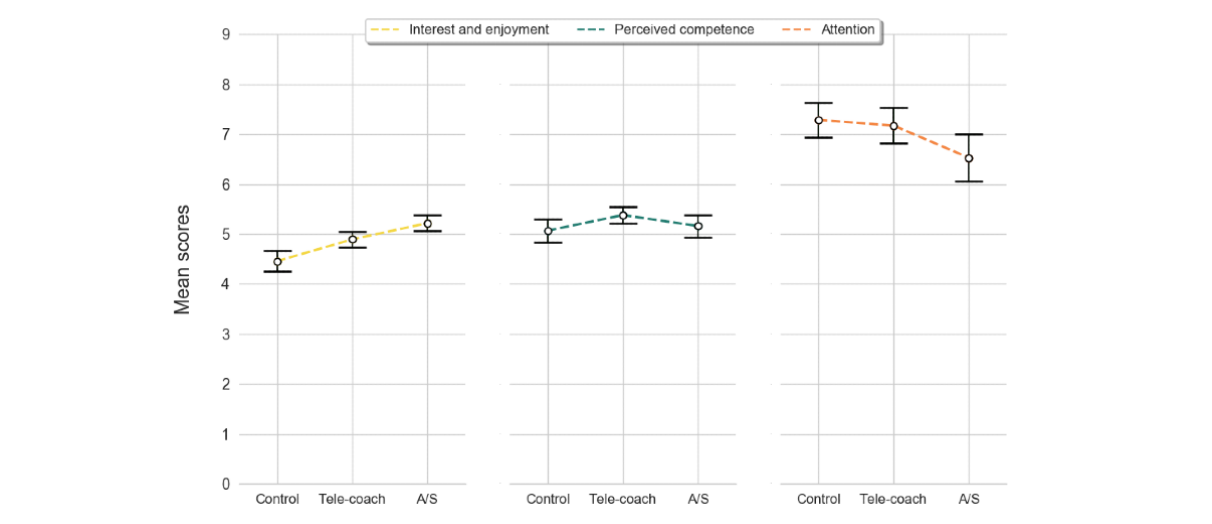
Figure 8. Distributions (mean and SE bars) of scores for psychophysiological measures from left to right: interest/enjoyment, perceived competence, and attention, reported per set. A/S: ambient light and